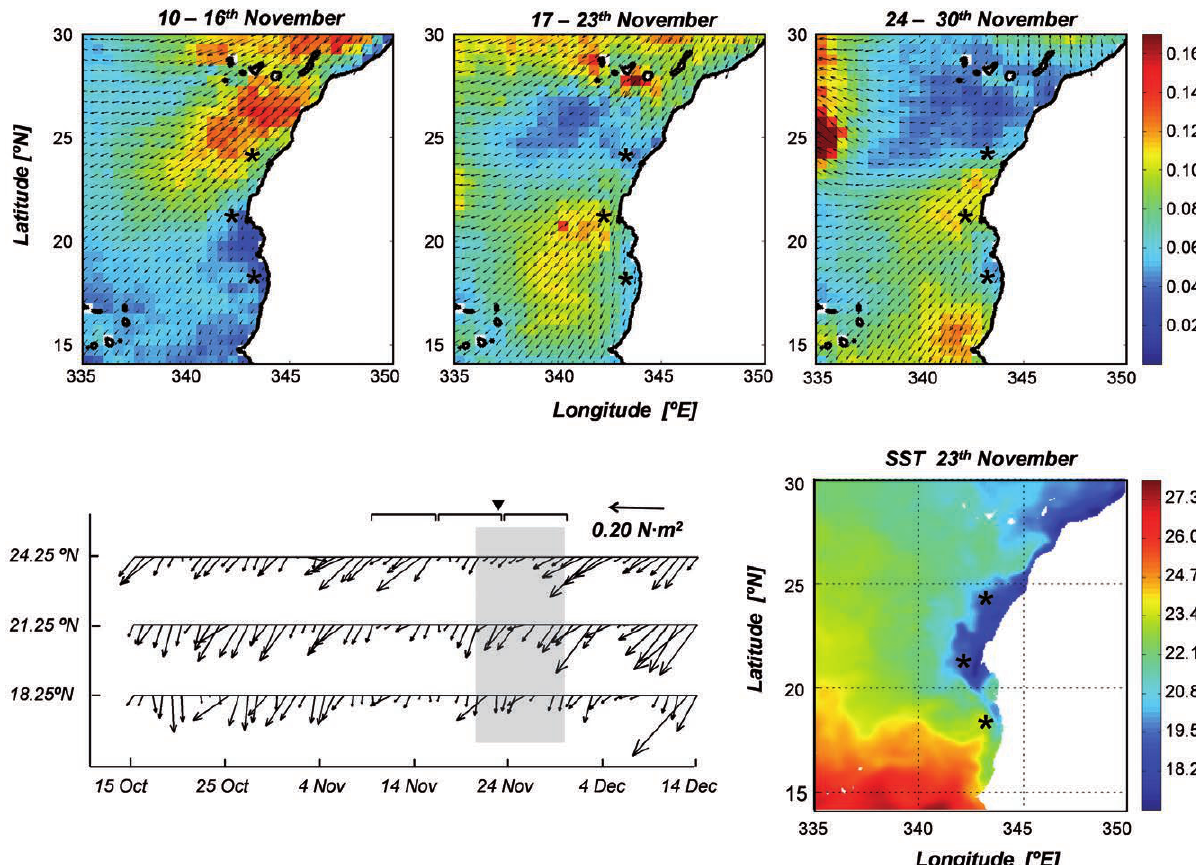
F ig . 2. – Top panels: Weekly-averaged wind stress fields [N m –2 ] for three consecutive weeks, starting on 10, 17 and 24 November 2008. Bottom left panel: Temporal series of the surface wind stress vector at three different latitudes over the slope (asterisks in top panels). The shaded area, the top brackets and the tick mark indicate the duration of the cruise, the average intervals for the wind stress field, and the day of the SST image, respectively (source: QuikSCAT). Bottom right panel SST [°C] on 23 November 2008, as obtained from